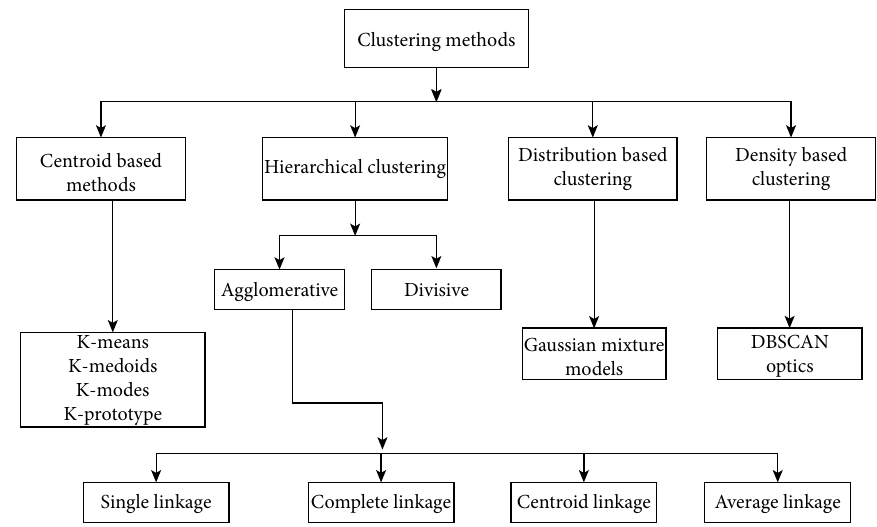
Figure 1: Different types of clustering